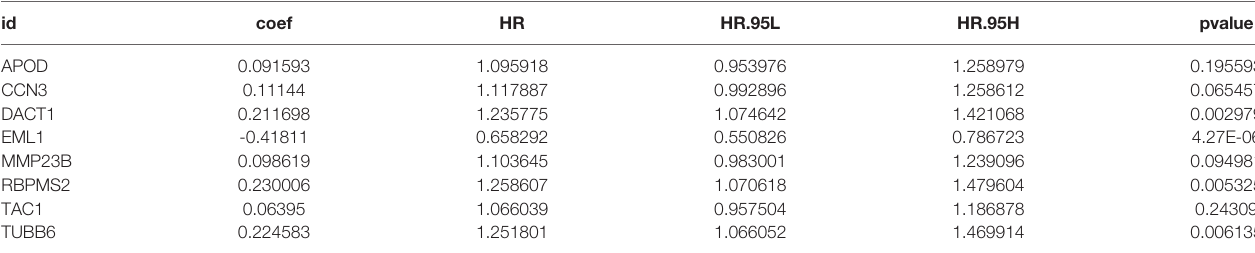
TABLE 1 | Information of 8 m6A-related hypoxia pathway